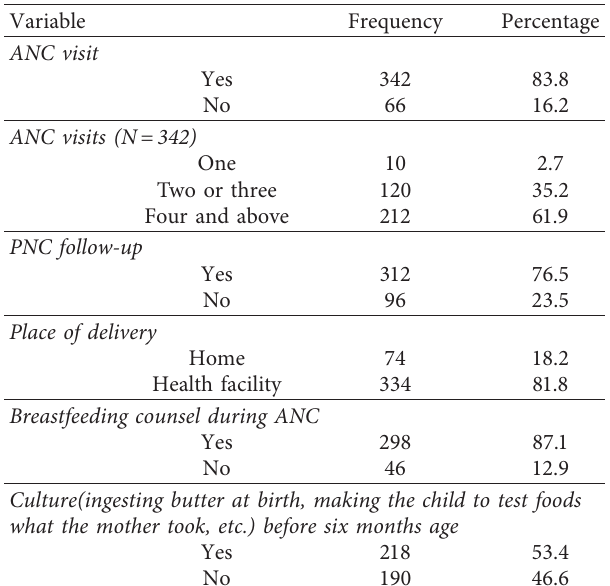
Table 2: Maternal and child health service utilization character- istics of study participants in Ethiopia,